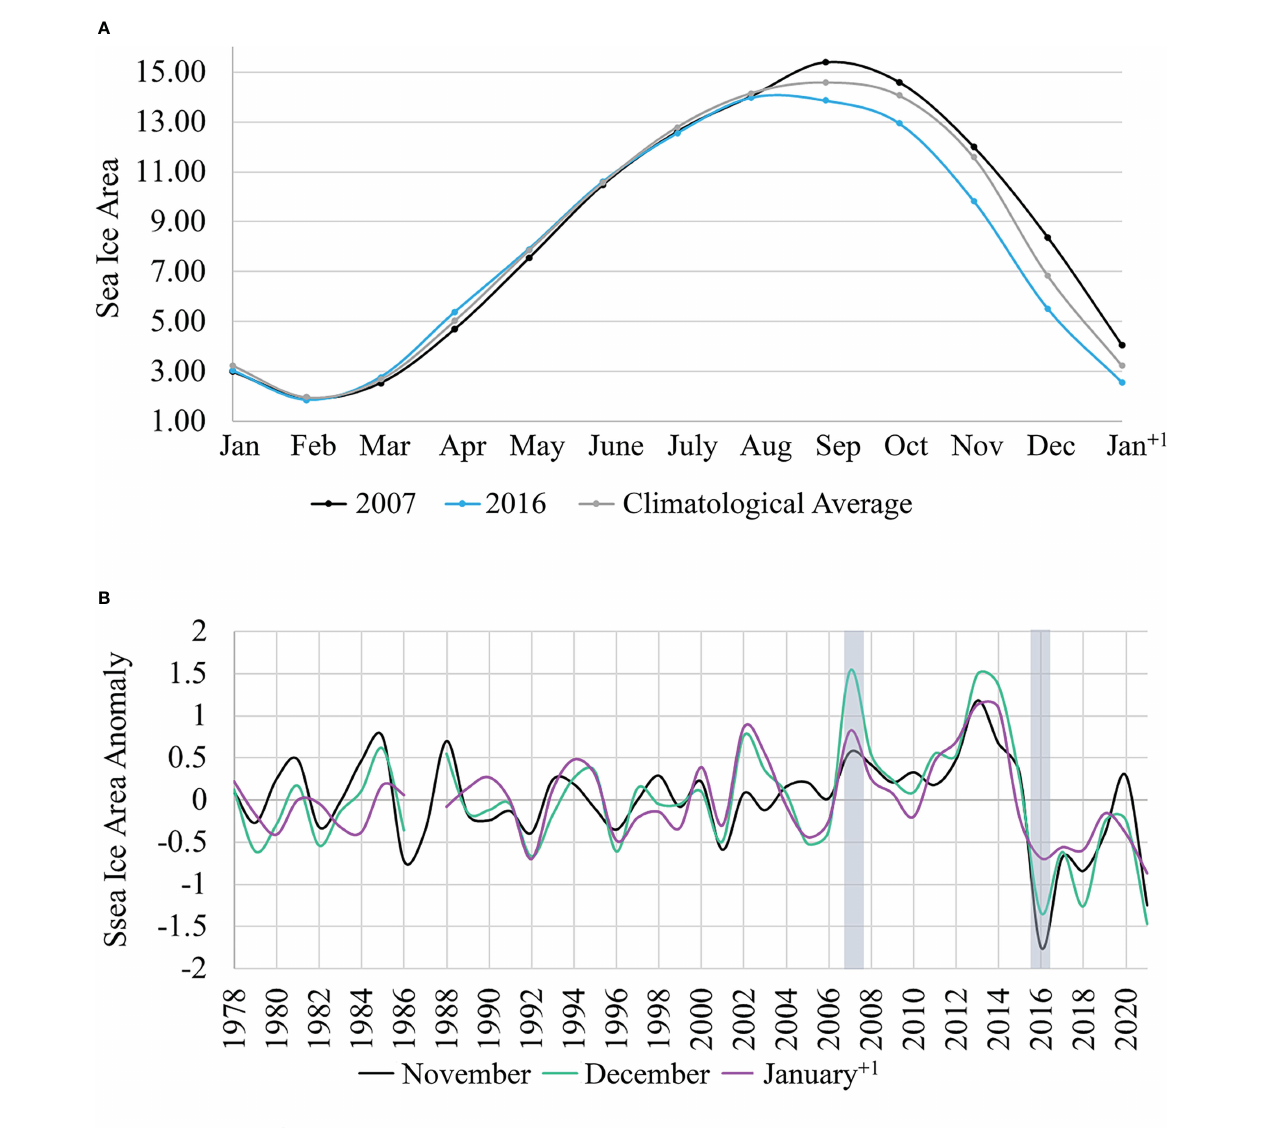
FIGURE 8 (A) Monthly sea ice area [million km 2 ] from 2007, 2016 and on average from the 1979 – 2021 record. (B) Sea ice area anomaly (million km 2 ) from the mean ice area record in November, December, and proceeding January (austral summer). The winters of interest (2007 and 2016) are shaded